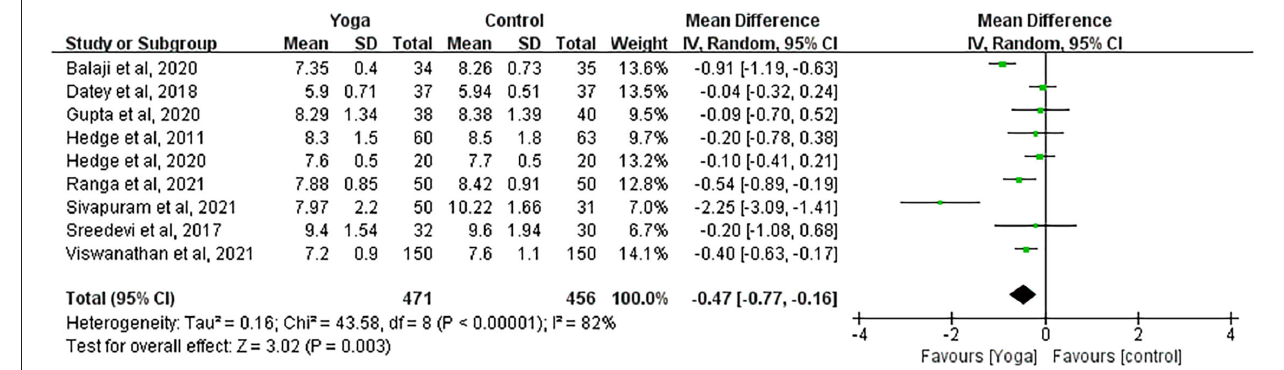
FIGURE 4 | Forest plots for the effect of yoga on HbA1c.